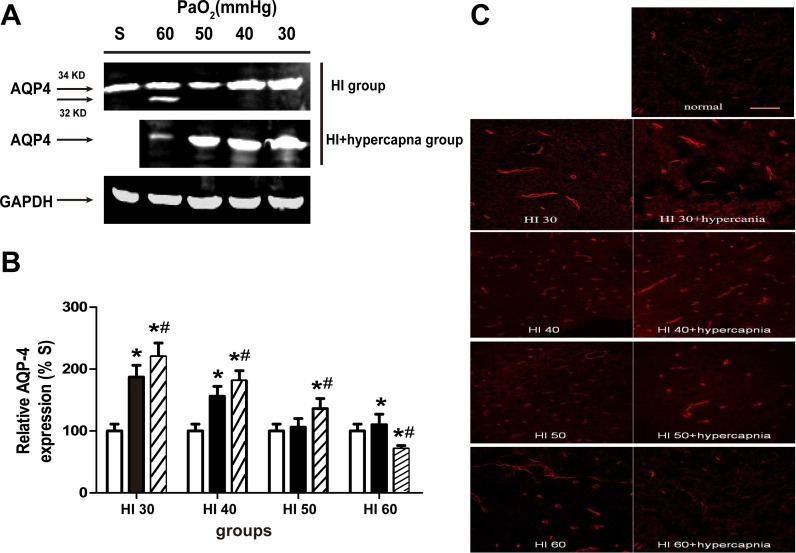
Effects of hypercapnia on the expression of aquaporin-4 (AQP4) in the ischemic cortex of rats in the S group.(A) Western blot analyses of AQP4 expression and (B) densities of AQP4 expression relative to GAPDH in the sham and the HI30, HI40, HI50, and HI60 groups (B) alone or with hypercapnia. Clear bars are shams (S group), black bars are hypoxia (HI) and striped bars are hypoxia with hypercapnia (HI+hypercapnia). Data are expressed as mean ± SD. (n = 3). *p < 0.05 vs. Sham, #p < 0.05 vs. HI groups only. (C) Immunofluorescence labeling of AQP4 in the ischemic cerebral cortex. Magnification, ×20. Scale bar = 100 μm.